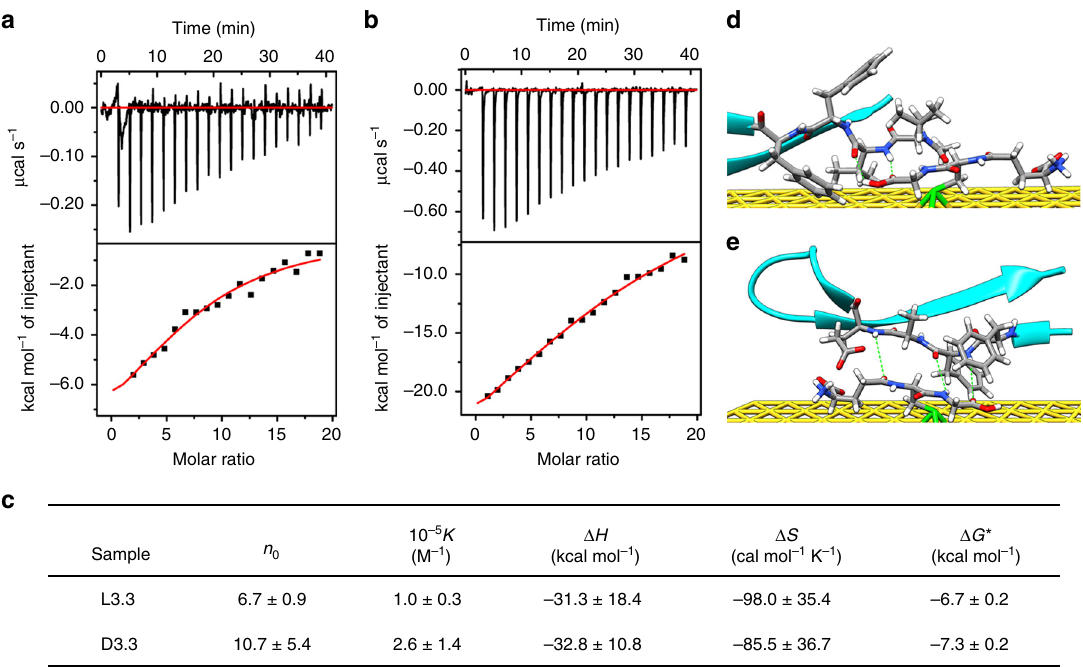
Fig. 2 Analysis of interaction between L3.3/D3.3 and A β 42 monomer. a , b Typical ITC data for titration of A β 42 (0.138 mM) into solution of L3.3 (1.5 μ M) ( a ) and D3.3 (1.5 μ M) ( b ) at 25 °C. (Upper) raw data and (lower) integrated data. The solid curves represent the best- fi t results using a one-site binding model. The experiment was repeated for three times. c Summary of binding stoichiometry n 0 , binding constant K , enthalpy changes Δ H , entropy changes Δ S , and Gibbs free energy changes Δ G of binding process of A β 42 monomer on L3.3 ( a ) and D3.3 ( b ). Error bars indicate mean ± s.d. * P < 0.05, two-sided Student ’ s t test. For detailed statistical analysis see Supplementary Table 7. d , e The most stable structures of A β 17-36 with L - ( d ) and D -GSH- coated Au (111) surface ( e ) obtained from molecular docking simulation (atom color: C, gray; H, white; N, blue; O, red; S, green; Au, yellow). Green dotted lines represent hydrogen bonding. Source data are provided as a Source Data fi